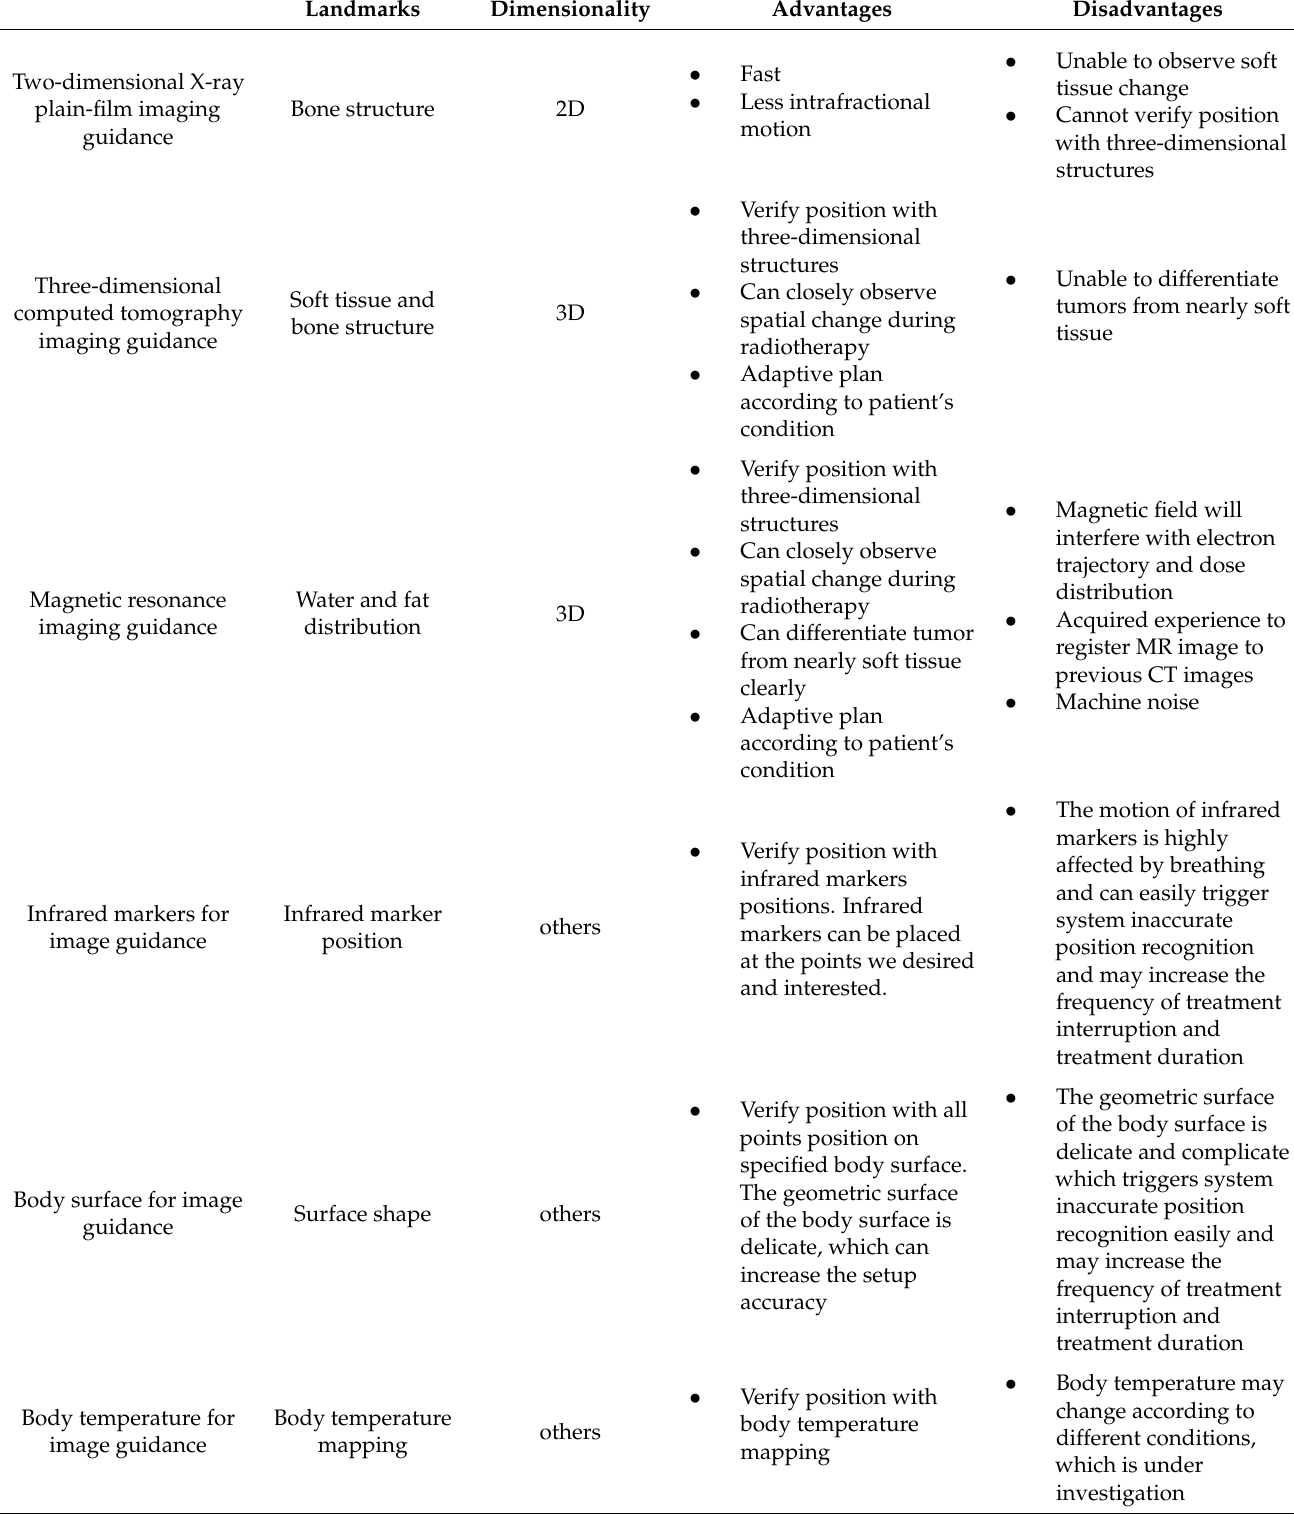
Table 1. Comparison advantages and disadvantages among different image